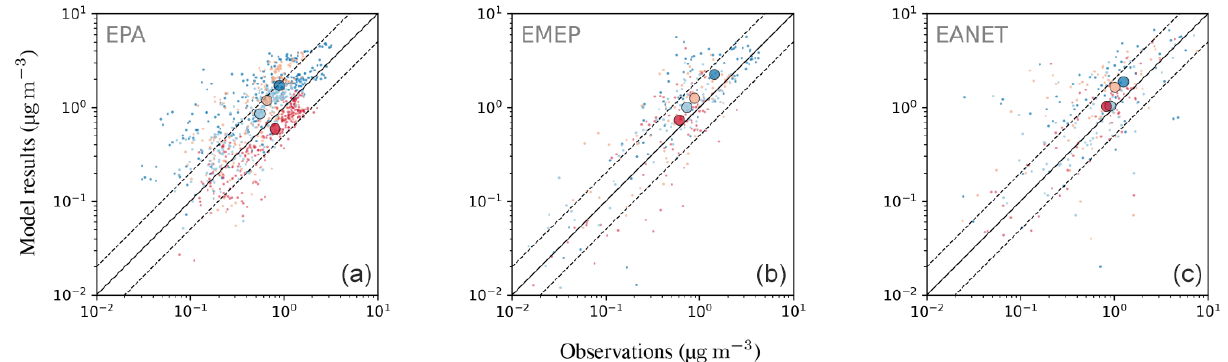
Figure 25. The same as Fig. 20 but for NH +